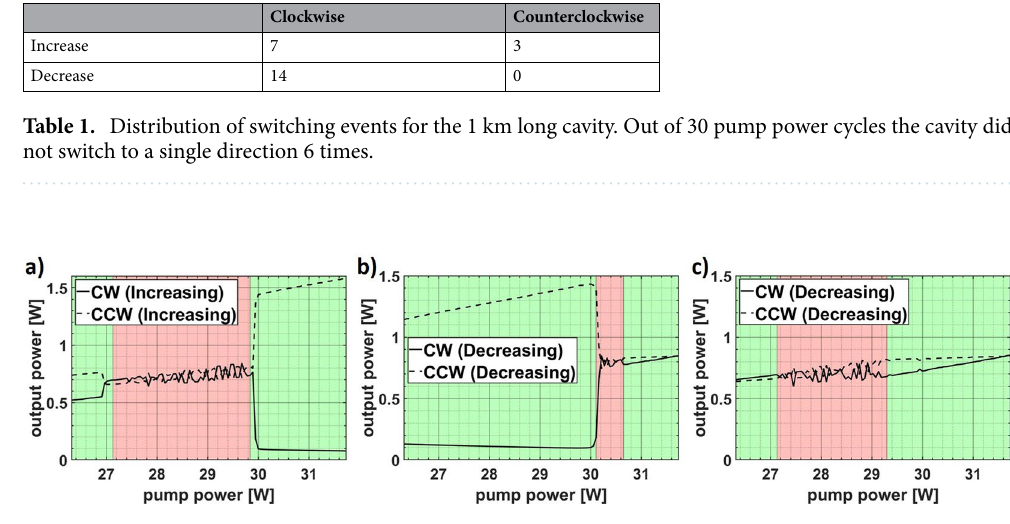
Figure 8. Detailed plots regarding the output power behavior for switching events happening ( a ) during power increase, ( b ) during power decrease, or ( c ) not at all. Regions with a fluctuating power trend are highlighted in red and with smooth trend in